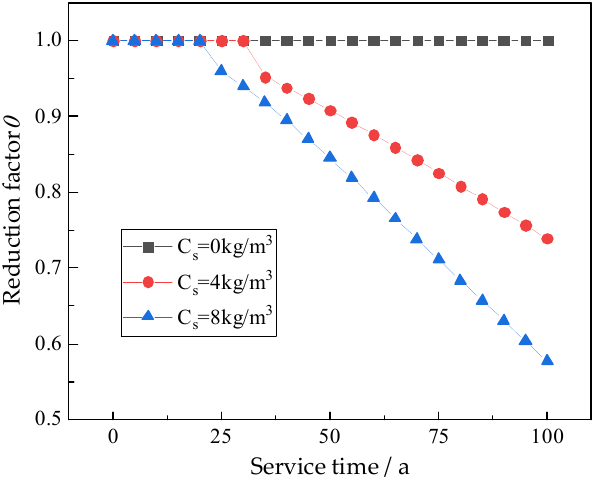
Figure 6. The relationship between reduction factor and service time. As shown in Figure 6, a similar attenuation law of pile bending stiffness is created by different environments. When the critical concentration of chloride on the surface of the steel bar is 0.65 kg/m 3 [30], the initial corrosion time of the pile is the 34th year and 22nd year with the conditions of chloride concentration of 4 kg/m 3 and 8 kg/m 3 , respectively.